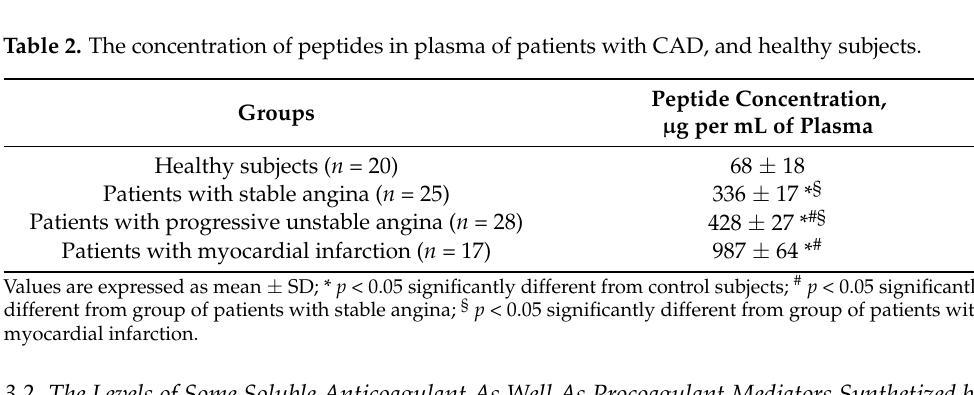
Table 1. The main clinical characteristics of patients with CAD, and healthy subjects. Patients with Patients with Patients with Healthy Subjects Progressive Stable Angina Myocardial ( n = 20) Unstable Angina ( n = 25) Infarction ( n = 17) ( n = 28) Age, years 53 ± 6 63 ± 8 67 ± 7 61 ± 7 Sex, male, n (%) 10 (50) 15 (60) 14 (50) 11 (65) Smoking, n (%) 7 (35) 9 (36) 11 (39) 6 (35) BMI, kg/m 2 27 ± 4 29 ± 6 29 ± 3 28 ± 6 TC, mmol · L − 1 5.14 ± 0.99 5.96 ± 1.64 6.39 ± 2.18 5.28 ± 0.94 TG, mmol · L − 1 1.28 ± 0.43 2.50 ± 0.70 2.21 ± 1.12 3.29 ± 1.17 * LDL, mmol · L − 1 2.38 ± 0.47 3.39 ± 1.38 3.75 ± 1.19 3.29 ± 1.17 HDL, mmol · L − 1 1.64 ± 0.45 1.64 ± 0.87 1.31 ± 0.51 0.85 ± 0.24 * TP, g · L − 1 13.8 ± 4.0 10.4 ± 5.0 § 11.5 ± 4.6 § 35.5 ± 11.8 * hs-cTnI, pg · mL − 1 ≤ 5 ≤ 5 17.6 ± 9.2 * #§ 24.3 ± 10.2 * #